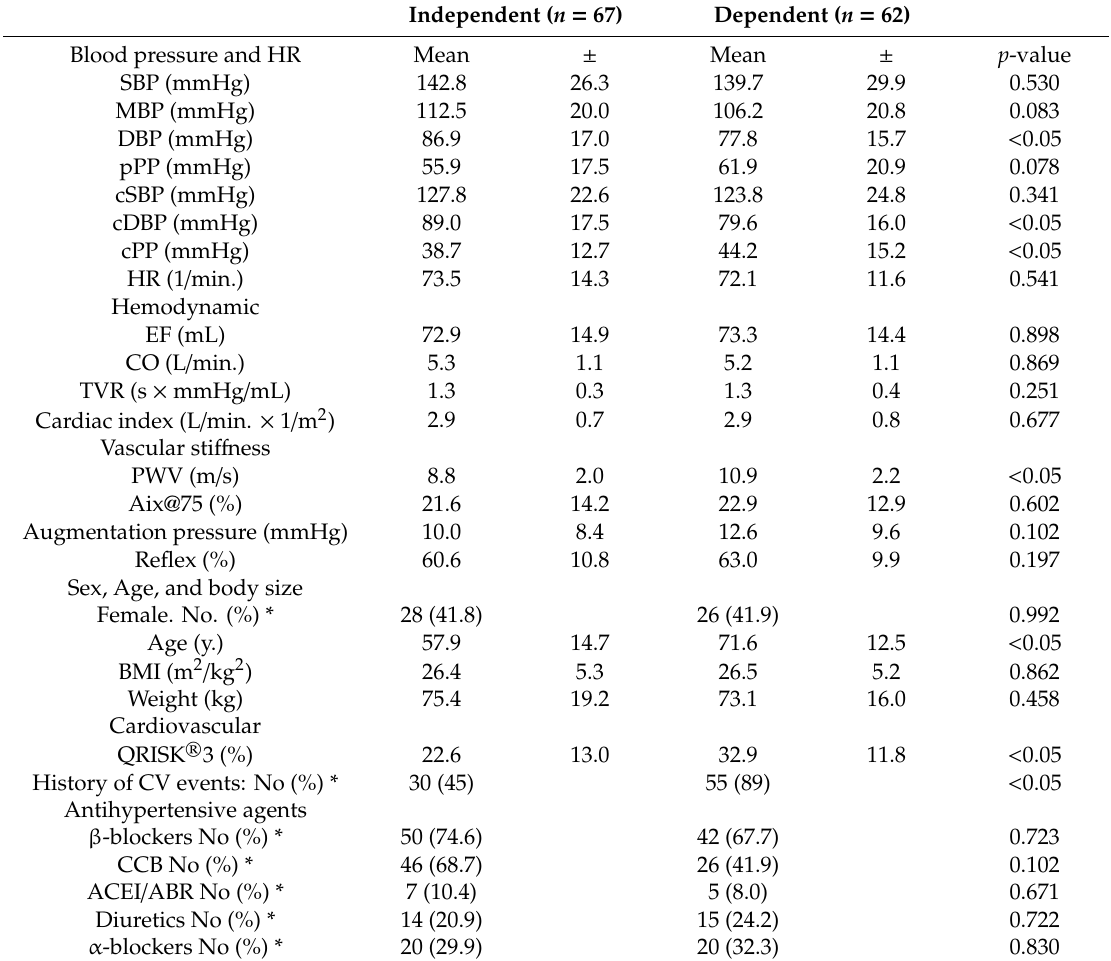
Table 1. Baseline characteristics of the groups: independent (80–100 points on the Barthel index) and dependent patients ( < 80 points on the Barthel index).